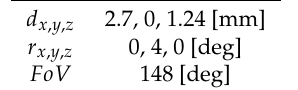
Table 4. Monocular camera sensor model